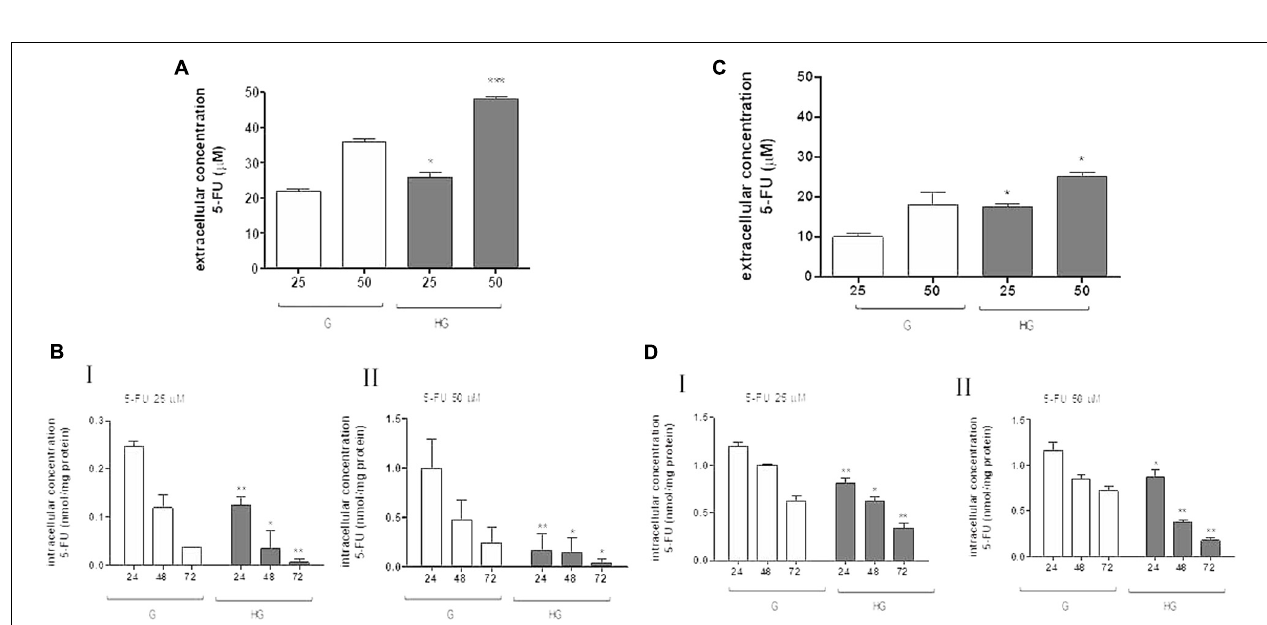
FIGURE 6 | Effect of normal glucose (G) and high glucose (HG) on accumulation of 5-FU in human colon cancer HT29 and LOVO cells. Cells were cultured for ≥ 7 days in the presence of G and HG and incubated with 25 and 50 µ M 5-FU for 72 h before analysis, then subjected to the following investigations. (A) The extracellular content of 5-FU (A,C) was assessed by HPLC. The measurements were performed in duplicate and data are presented as mean ± SEM ( n = 4). ∗ p < 0.05 25 µ M 5-FU in HT29 cells cultured in HG vs. G; ∗∗∗ p < 0.0001 50 µ M 5-FU in HT29 cells cultured in HG vs. G. ∗ p < 0.05 25 µ M 5-FU in LOVO cells cultured in HG vs. G; ∗ p < 0.05 50 µ M 5-FU in LOVO cells cultured in HG vs. G. (B) The intracellular drug content of 5-FU (B,D) was assessed by HPLC-MS. The measurements were performed in triplicate and data are presented as mean ± SEM ( n = 3). At 25 µ M 5-FU (B - I) : ∗∗ p < 0.001 in HT29 cells cultured in HG vs. G at 24 h; ∗ p < 0.05 in HT29 cells cultured in HG vs. G at 48 h; ∗∗ p < 0.001 in HT29 cells cultured in HG vs. G at 72 h. At 25 µ M 5-FU (D - I) : ∗∗ p < 0.001 in LOVO cells cultured in HG vs. G at 24 h; ∗ p < 0.05 in LOVO cells cultured in HG vs. G at 48 h; ∗∗ p < 0.001 in LOVO cells cultured in HG vs. G at 72 h. At 50 µ M 5-FU (B - II) : ∗∗ p < 0.001 in HT29 cells cultured in HG vs. G at 24 h; ∗ p < 0.05 in HT29 cells cultured in HG vs. G at 48 h; ∗ p < 0.05 in HT29 cells cultured in HG vs. G at 72 h. At 50 µ M 5-FU (D - II) : ∗ p < 0.05 in LOVO cells cultured in HG vs. G at 24 h; ∗∗ p < 0.001 in LOVO cells cultured in HG vs. G at 48 h; ∗∗ p < 0.001 in LOVO cells cultured in HG vs. G at 72